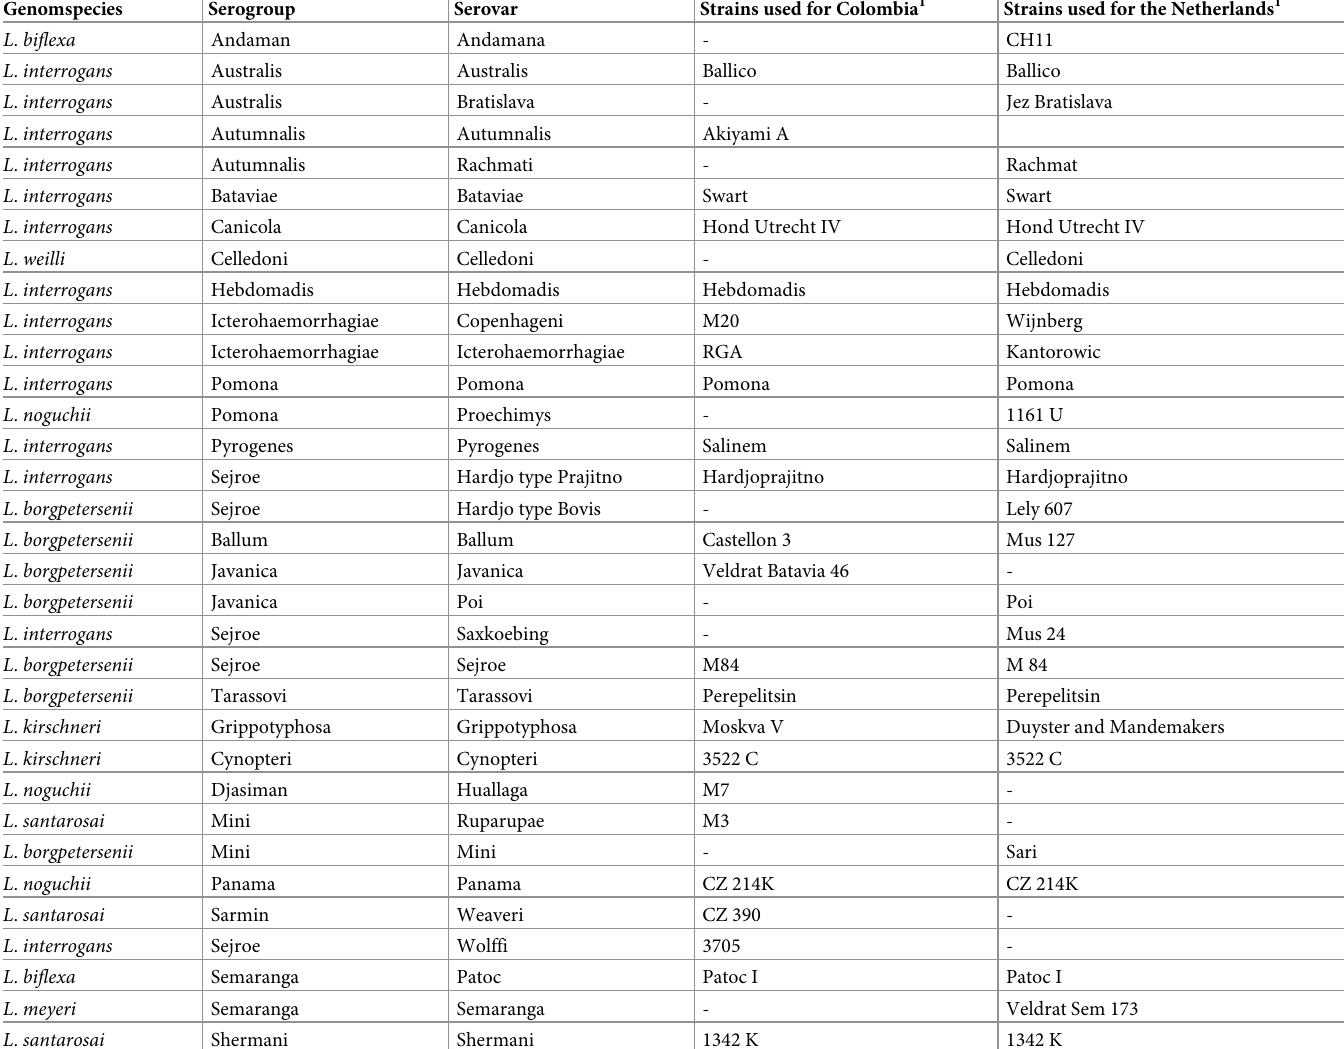
Table 3. Strains, serogroups and serovars of Leptospira spp. used as live antigens in the Microscopic Agglutination Test (MAT) for the populations in the Nether- lands (N = 14), and Colombia (N = 156).